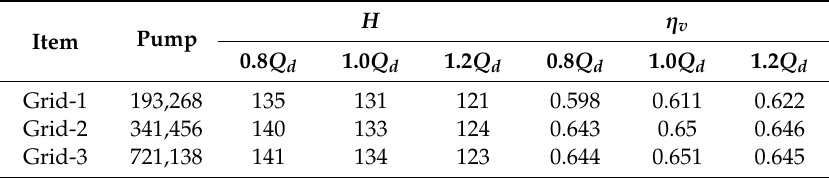
Table 3. Pump performance with di ff erent mesh